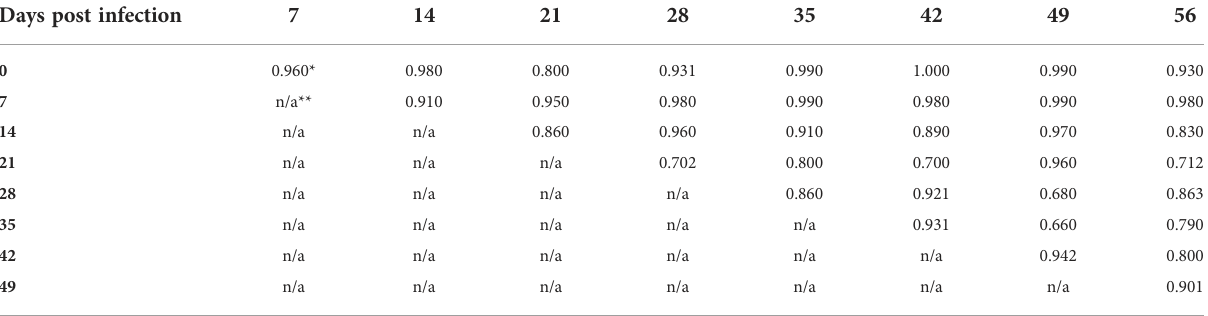
TABLE 3 The accuracy of identi fi cation of B. afzelii PGau infection in C3H mice at different time points postinfection as measured by the Matthew ’ s Correlation Coef fi cient. Days post